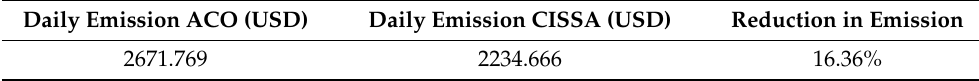
Table 8. Reduction in total daily emissions—case study 1.